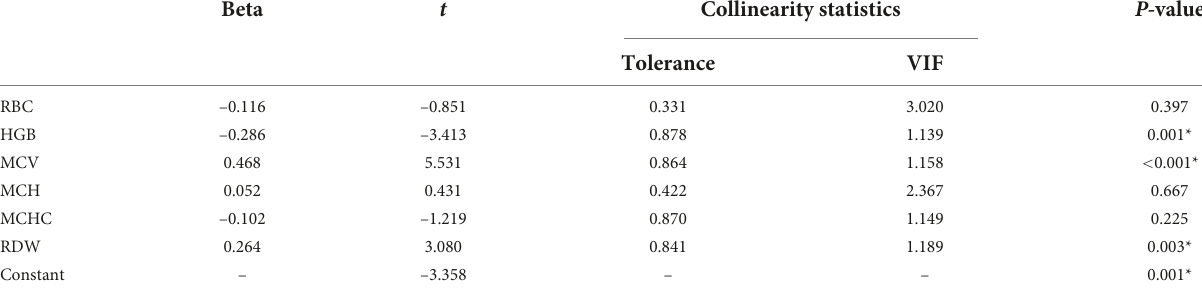
TABLE 2 Multi-collinearity diagnostics of RBC